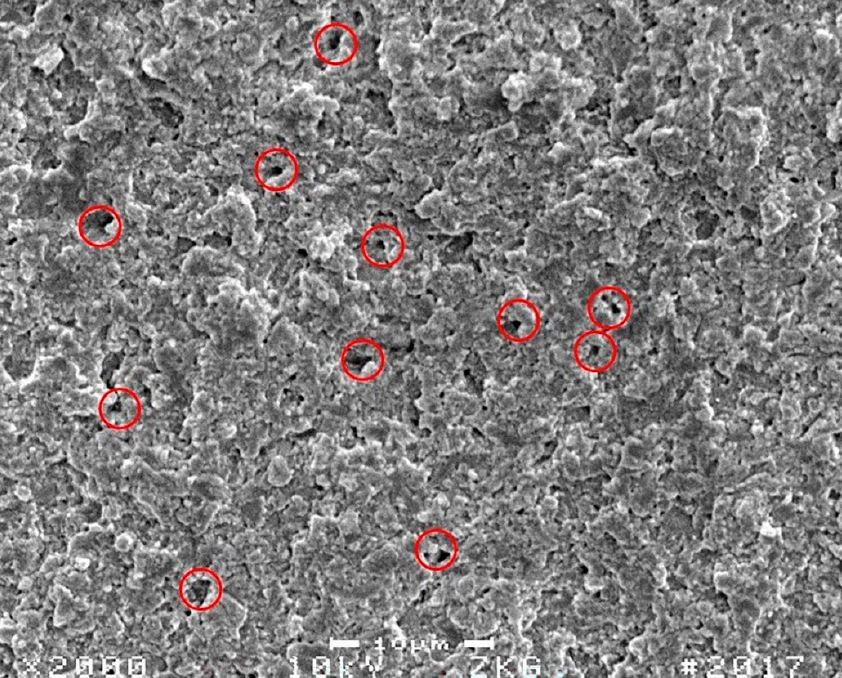
Figure 11. Representative SEM image of a selected CGF fracture surface. Red circles exemplarily denote material